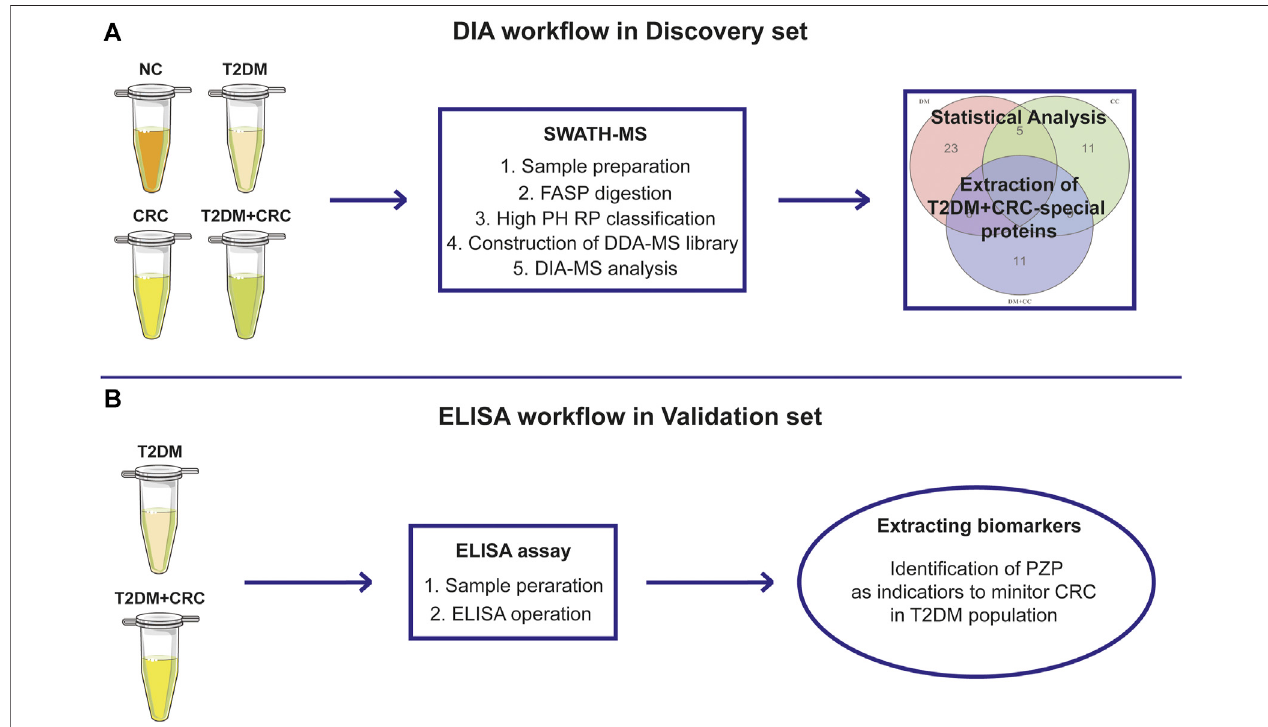
FIGURE1| Theoveralldesignofthecurrentstudy.SchematicillustrationofthediscoveryprocedureforthescreeningofpotentialdiagnosticbiomarkersforCRCin T2DM patients based on the DIA-MS method (A) and the validated procedure based on ELISA analysis (B) .